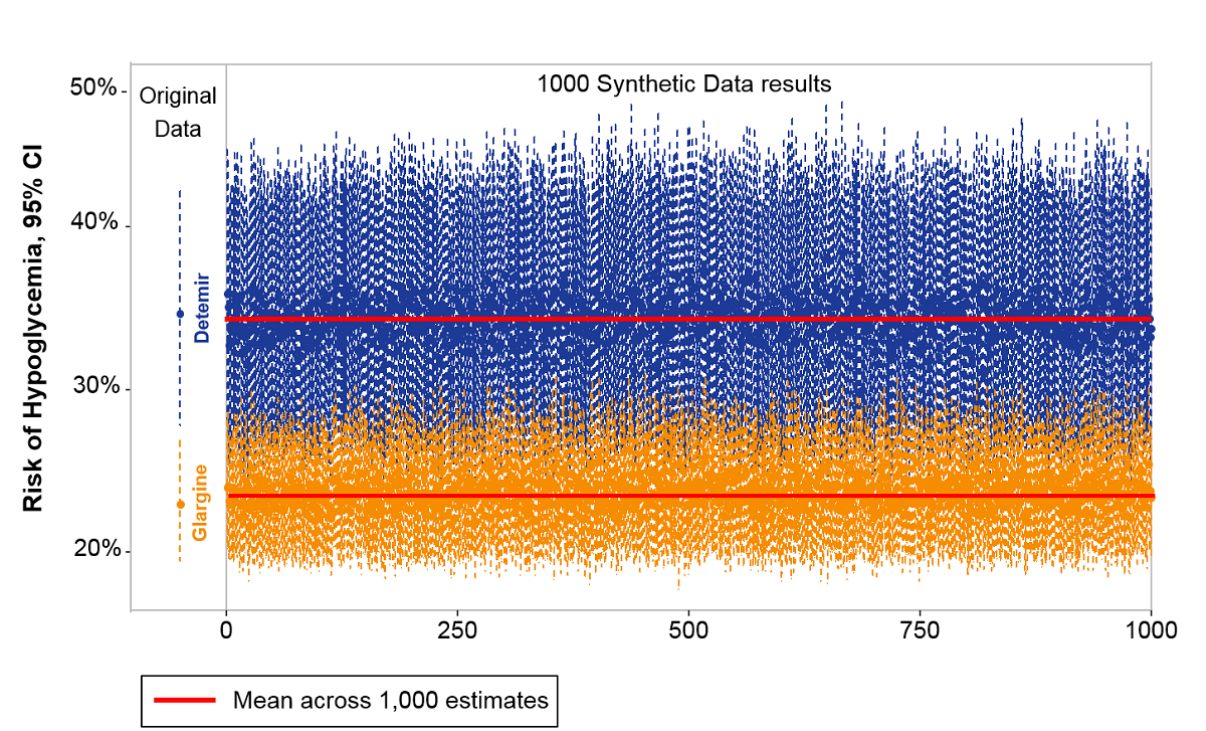
Figure 8. Risk predictions at albumin 2 gr/dL for 1000 repeatedly generated synthetic sets, compared to estimates obtained from the real sets (thin dotted line on the left marks the confidence intervals with the point estimates marked on the line). All synthetic sets predicted a higher hypoglycemia rate for detemir, and all were within the confidence limits of the estimates from the real data. The synthetic data estimates, as showed by their means (thick red lines), are biased from the real data estimates by –0.003 for detemir and by +0.006 for